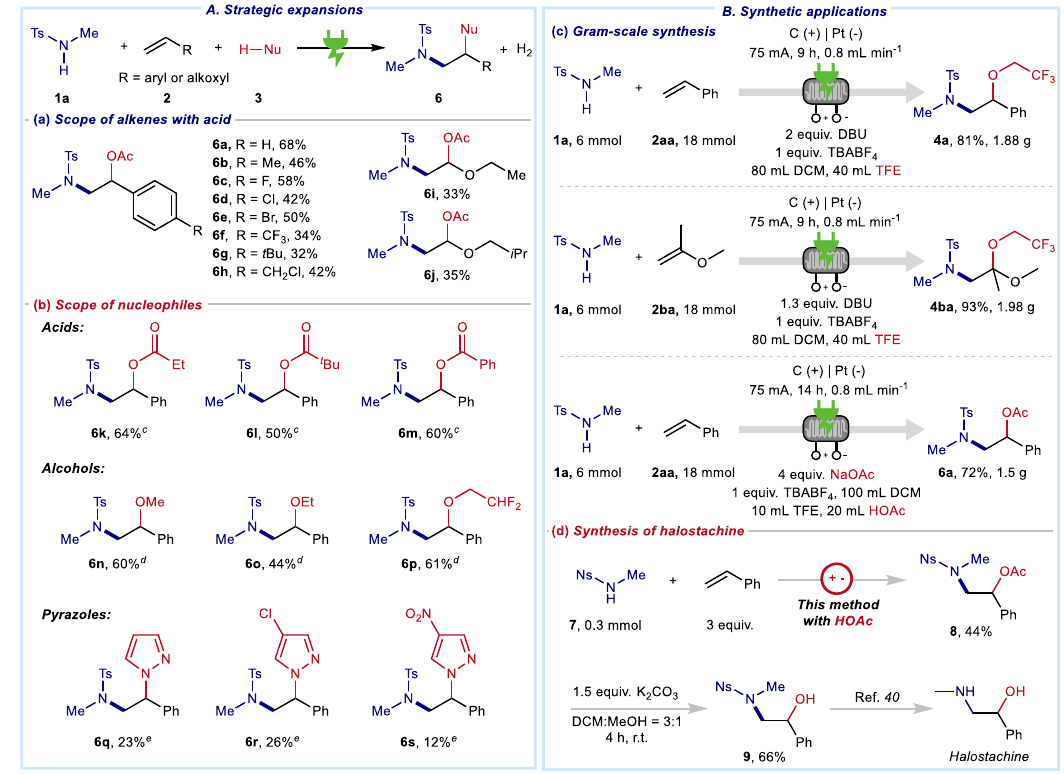
Fig. 3| Strategicexpansionsand syntheticapplications.A Strategicexpansions. a Scope of alkenes with acids. a Reaction conditions: 1a (0.3mmol), alkenes (1.8mmol), acetic acid 36% aqueous solution (AR, HOAc) (1.0mL), TBAOAc (0.3mmol), NaOAc (1.2mmol) as base, in DCM/TFE (5mL/0.5mL), C anode, Pt cathode,undividedcell,6mA,roomtemperature,N 2 ,5.0h,isolatedyield. b .Scope of nucleophiles. c Reaction condition: TBABF 4 (0.3mmol), acids (1.8mmol) and